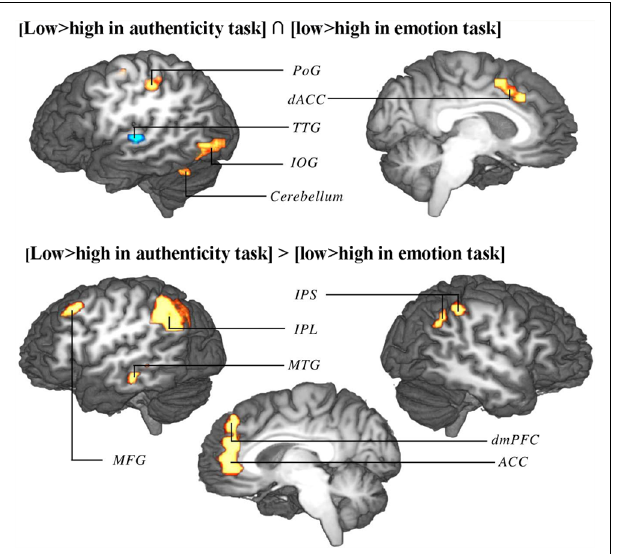
FIGURE 5 | Conjunction (top) and disjunction (bottom) of brain activation correlates of contour in authenticity task trials of study 1 and emotion task trials of study 2. Top: regions marked red up-regulated by low contour in both tasks, regions marked blue up-regulated by high contour in both tasks. Bottom: interaction of contour extremes and task type (regions up-regulated by one end of the contour range in one task and by the other end of the contour range in the other task). Shown are group-averaged statistical maps (study 1: n = 24; study 2: n = 18). Posterior probability maps with a threshold of 99.5% and 100 voxel minimum size. Activation was mapped onto the best average fit subject 3D anatomical map.Top: left view sagittal section. Bottom: left view sagittal section − 24 − 9 through midline. PoG, postcentral gyrus; dACC, dorsal anterior cingulate cortex;TTG, transverse temporal gyrus; IOG, inferior occipital gyrus; IPS, inferior parietal sulcus; IPL, inferior parietal lobule; MTG, middle temporal gyrus; MFG, middle frontal